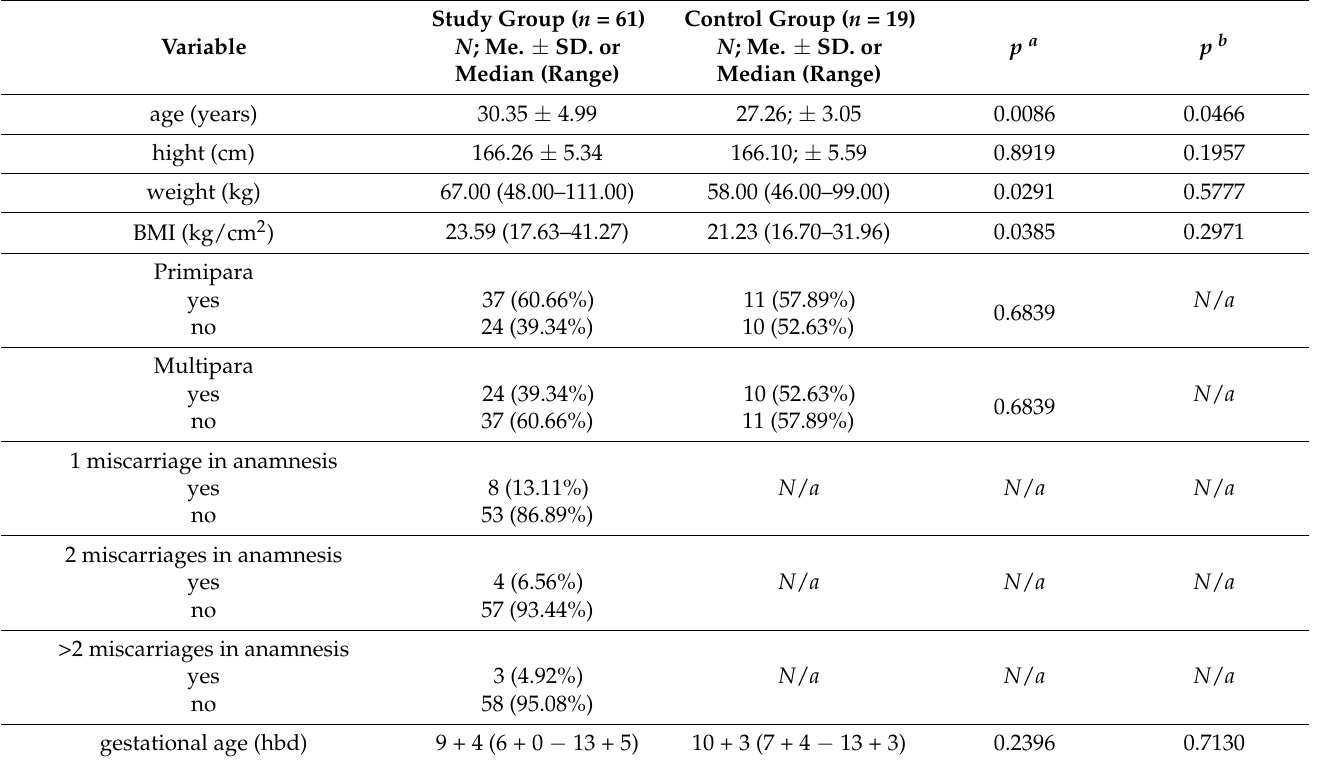
Table 1. Comparison and distribution of demographic and clinical data in the study and control